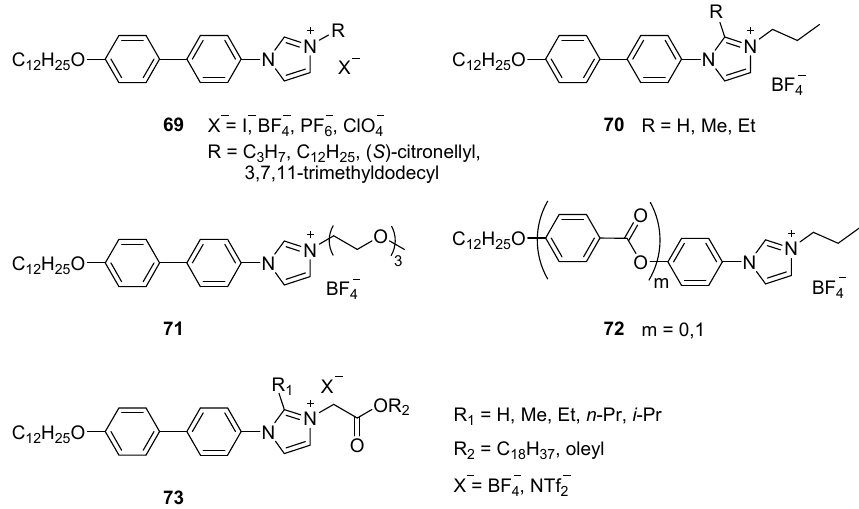
Figure 16. Di-imidazolium-based ILC to study steric ring effects.